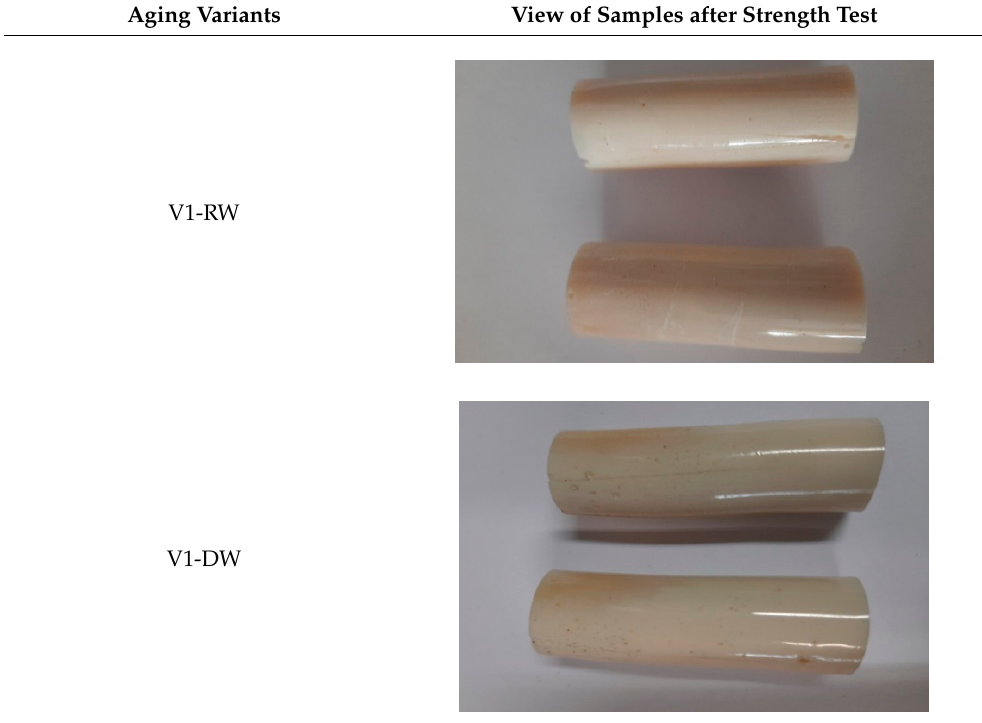
Table 5. View of the shape of the Epidian 57/Z-1/10:1 epoxy compound samples—variant I. Aging Variants